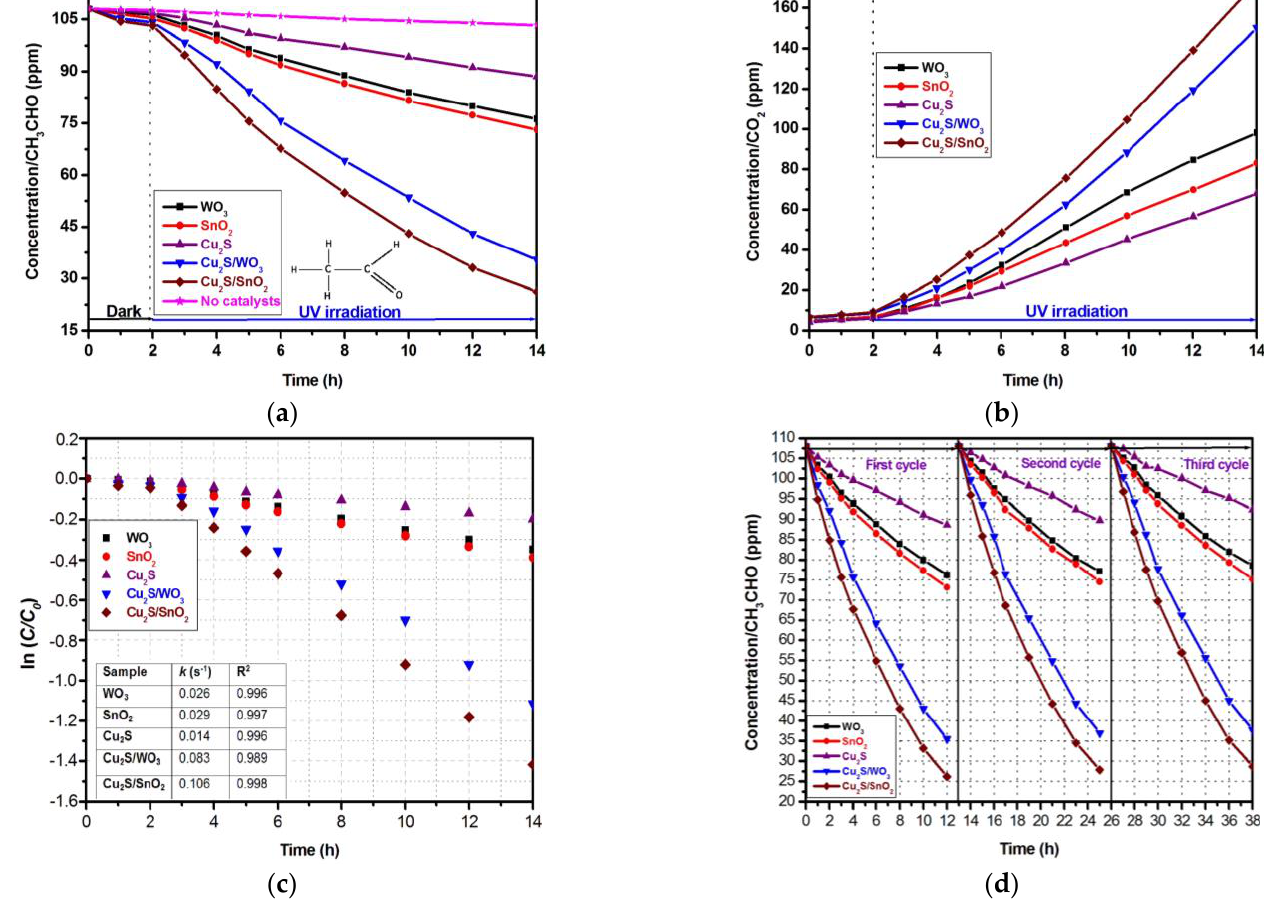
Figure 3. Photocatalytic activity of the mono-component and heterostructure samples: ( a ) acetaldehyde removal, ( b ) CO 2 formation, ( c ) kinetic evaluation, and ( d ) long stability